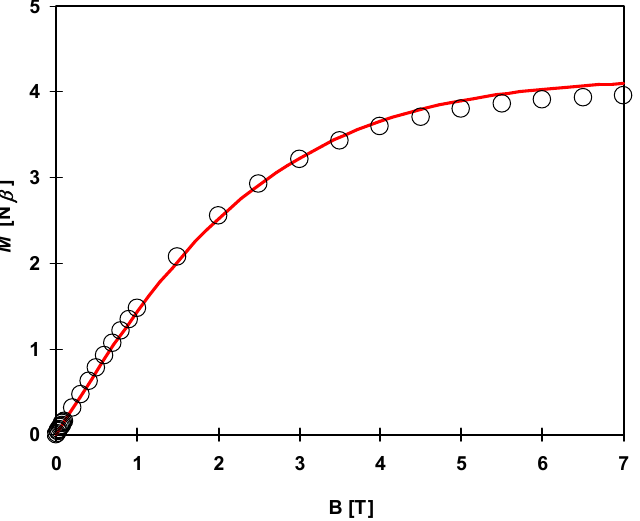
Figure 14. Field dependence of the magnetization for 2 at 2 K. The solid red line is the best fit for the model described in the text.